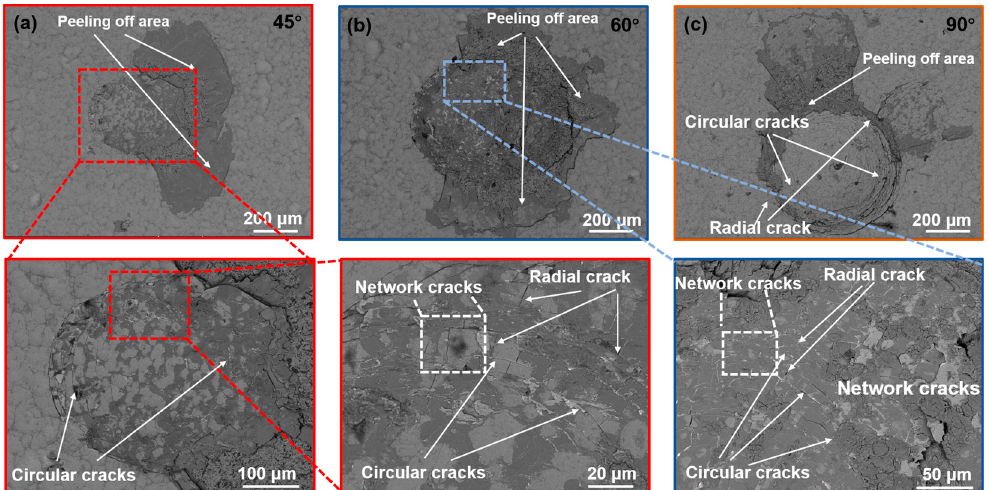
Figure 6. SEM micrographs of TiN/Ti coatings impacted under different angles: ( a ) Impacted under 45°, ( b ) impacted under 60°, and ( c ) impacted under 90°.